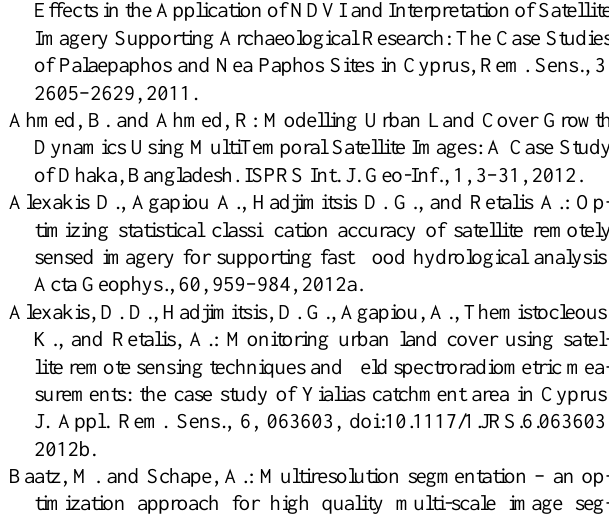
Fig. 9. Changes between curve number of 2000–2010 (a) and 2000–2020 (b)